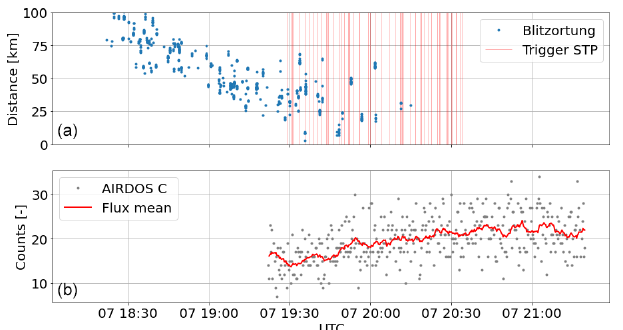
Figure 8. Lightning detected by Blitzortung.org and triggers from the STP antenna plotted together with individually registered parti- cles of ionizing radiation above channel 30 of the gamma spectrom-